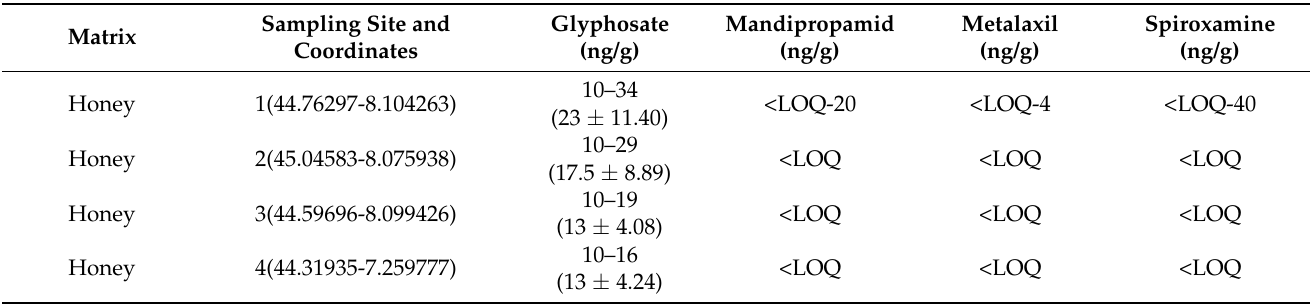
Table 3. Range, mean and standard deviation of pesticides found in bee bread samples coming from the different stations. Matrix Bee bread Bee bread Bee bread Bee